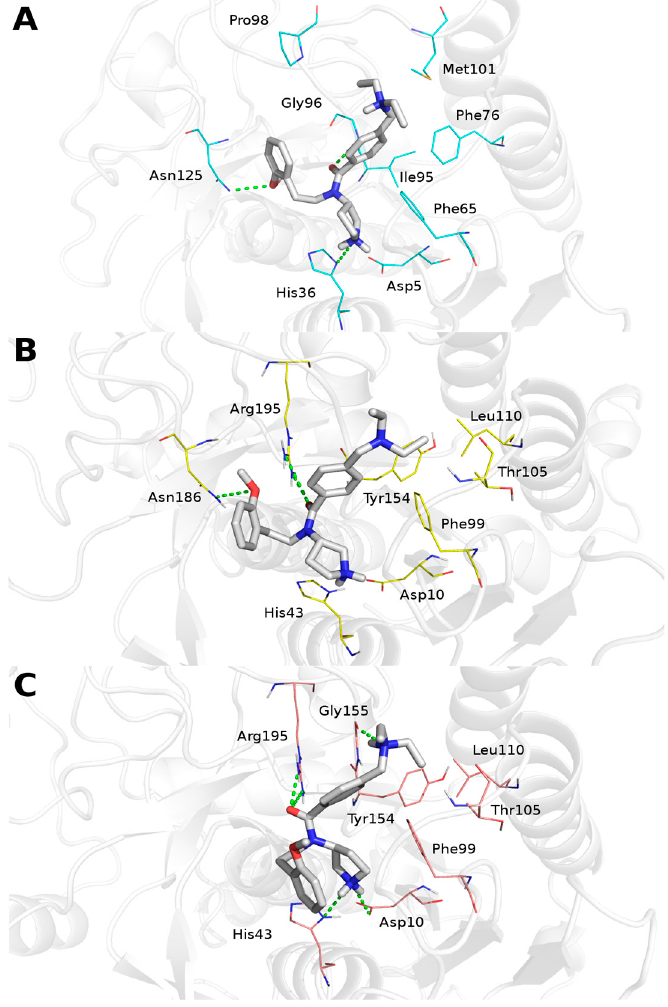
Figure 3. Suggested binding mode of PF-429242 (carbons in gray) in the subtilisin binding site. ( A ) Human subtilisin S1P (carbons in cyan), ( B ) L. amazonensis SUB (carbons in yellow), and ( C ) L. major SUB (carbons in pink). Protein residues in close contact with the inhibitor are shown as lines and labeled. Hydrogen bonding interactions are shown as a dotted green line. Secondary structures are shown as a transparent cartoon.